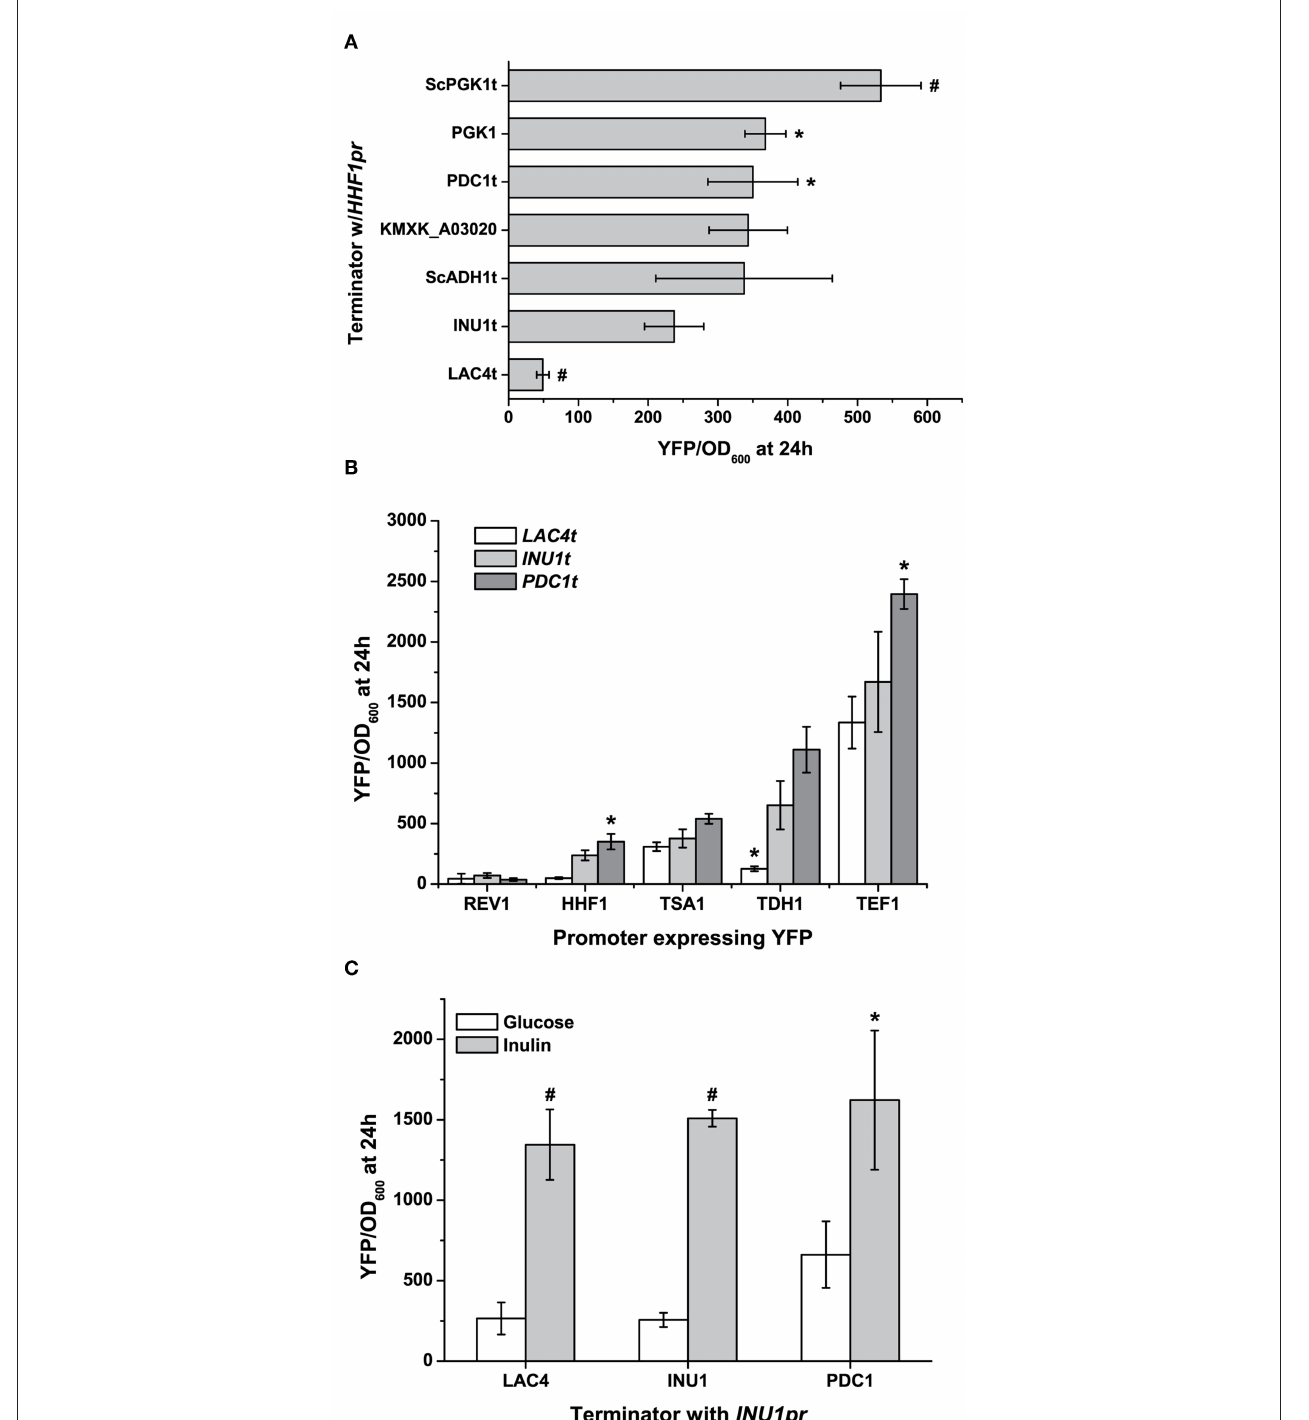
FIGURE 3 | Using terminators to fine-tune gene expression. (A) Terminator choice can change gene expression by a factor of nearly 5 using native terminators, and this range can be even further exchanged if terminators from S. cerevisiae are used. (B) This can further be used to control gene expression which promoters and terminators are used combinatorially, though the starting strength of the promoter can influence the range. (C) Inducible promoters’ expression is largely altered under non-inducing conditions when used to express YFP with different terminators. Here the strong induction of the inulinase ( INU1 ) promoter by inulin is not significantly affected by terminator choice, while it can affect leaky expression under non-inducing conditions. All data are plotted as the mean ± s.d. of at least three replicates. YFP values significantly different from those under baseline conditions (expression using INU1t ) are marked with an asterisk ( p < 0.05) or a hash ( p < 0.001).